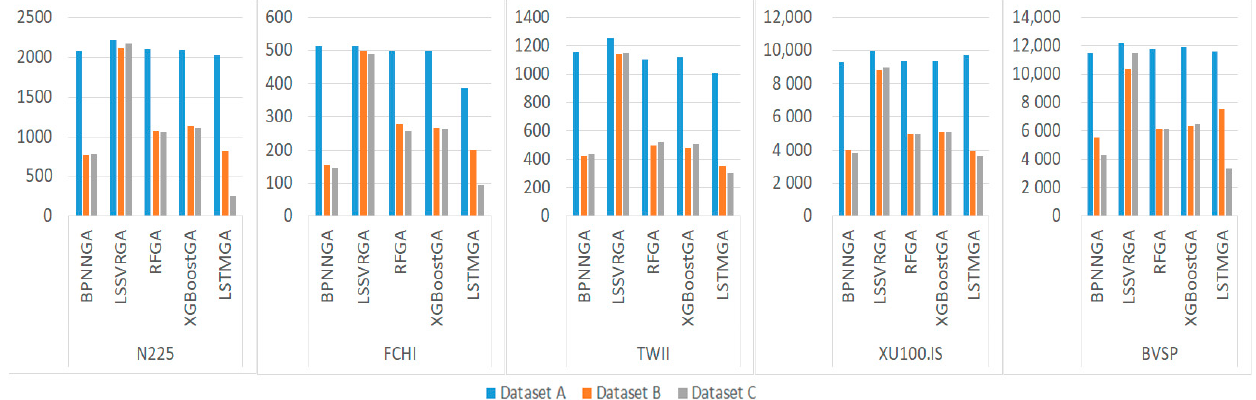
Figure 5. RMSE values of forecasting models for stock market indices with different datasets.